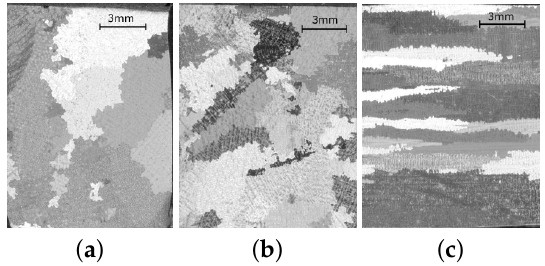
Figure 1. Microstructure of the MAR-M247DS alloy. The images ( a , b ) show the grains of the cross-section perpendicular to grain-growth direction, while the image ( c ) is in the parallel